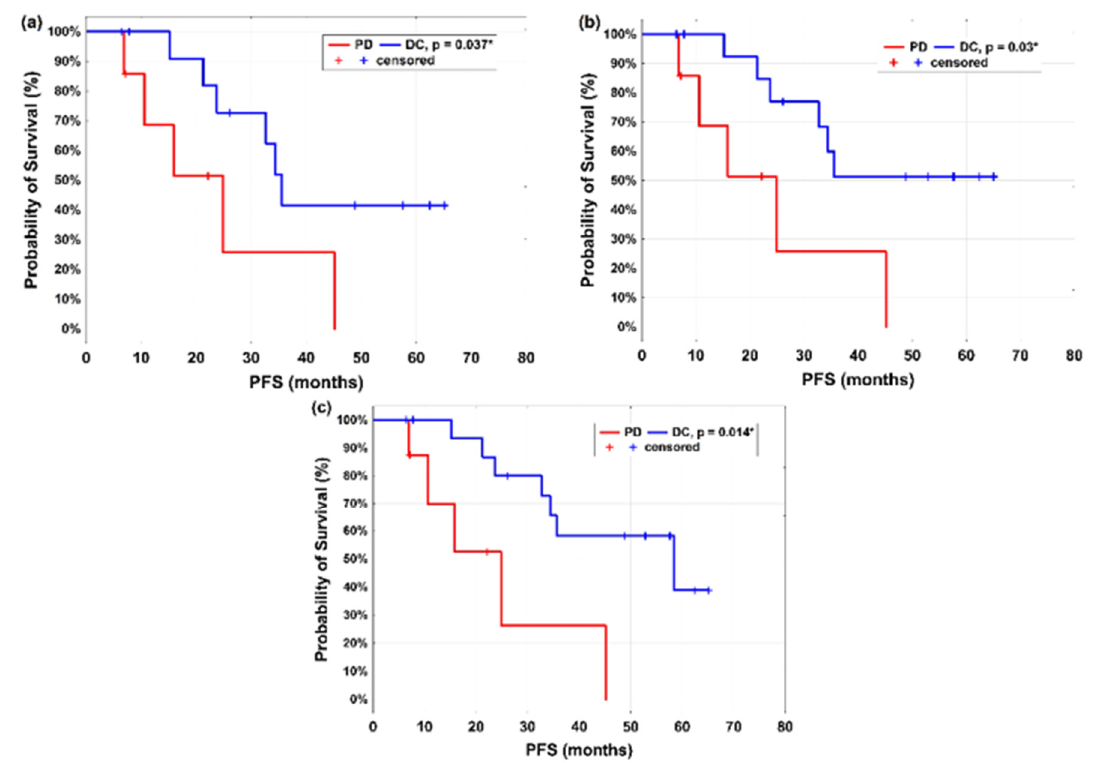
Figure 2. Kaplan–Meier estimate of PFS stratified as DC or PD by metabolic response ac- cording to ( a ) PERCIST 1.0 and mPERCIST, ( b ) PERCISTmax. and ( c ) EORTC (hottest lesion); PFS = progression-free survival; DC = disease control; PD = progressive disease; PERCIST 1.0 = PET Response Criteria in solid Tumors; EORTC = European Organization for Research and Treatment of Cancer; mPERCIST = modified PERCIST using SUVpeak; PERCISTmax = modified PERCIST using